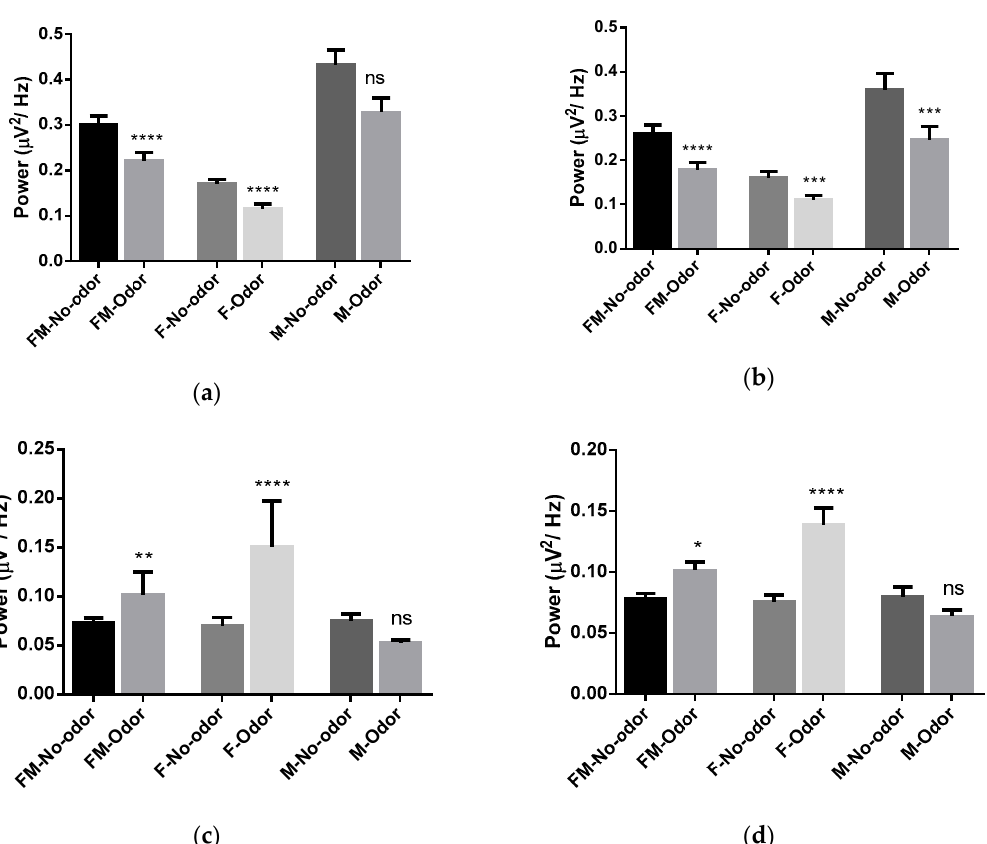
Figure 3. Brain area analysis of alpha wave activities of frontal and centro-temporal regions. ( a , b ) Slow alpha wave activities at frontal and centro-temporal regions, respectively. ( c , d ) Fast alpha wave activities at frontal and centro-temporal regions, respectively.; F, M, and FM represent female subjects, male subjects, and female and male subjects, respectively. ns, *, **, ***, and **** represent no statistical differences, p < 0.05, p < 0.01, p < 0.001, and p < 0.0001, respectively.